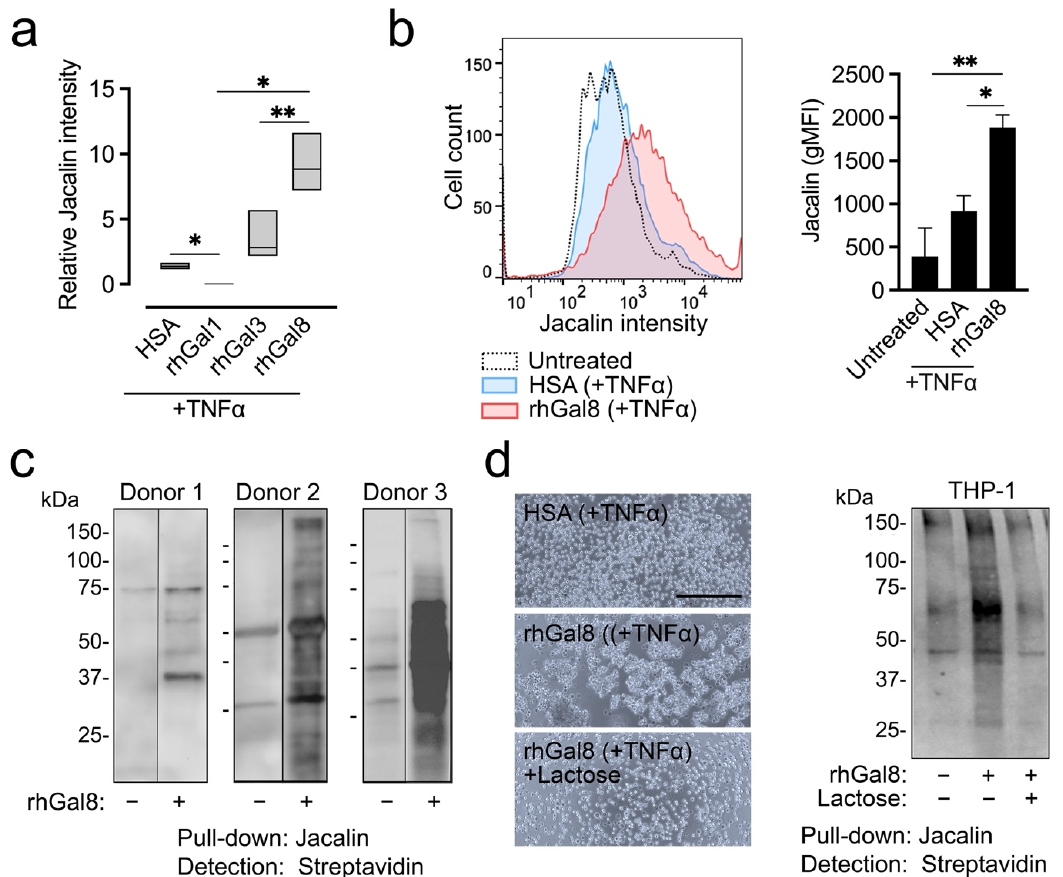
Figure 2. Galectin-8 induces Jacalin binding to human monocytes. ( a ) Human primary CD14 + CD16 − monocytes were treated with TNF α in the presence of human serum albumin (HSA) or recombinant human galectins (rhGal1, rhGal3, rhGal8) for 30 min. Untreated monocytes were used for fluorescence intensity normalization. Binding signals were derived from data in Figure 1a. The data are presented as floating bars (min. to max.) with the line at the median. Significance was determined using one ‐ way ANOVA with Greenhouse–Geisser correction. ( b ) Flow cytometry analysis of human primary monocytes stained with fluorescein-conjugated Jacalin (n = 3 independent donors). The data represent the mean ± SD. Significance was determined using one ‐ way ANOVA with Green ‐ house–Geisser correction. ( c ) Cell surface proteins on monocytes isolated from three human donors were labeled with biotin. The cell lysates were normalized for total protein and subjected to Jacalin pull ‐ down. Membranes were probed with streptavidin. ( d ) THP ‐ 1 monocytes were processed as indicated in ( c ). Experiments to determine carbohydrate dependence were carried out by preincubation of rhGal8 with 150 mM lactose. Scale bar, 250 μ m. *, p < 0.05; **, p < 0.01.